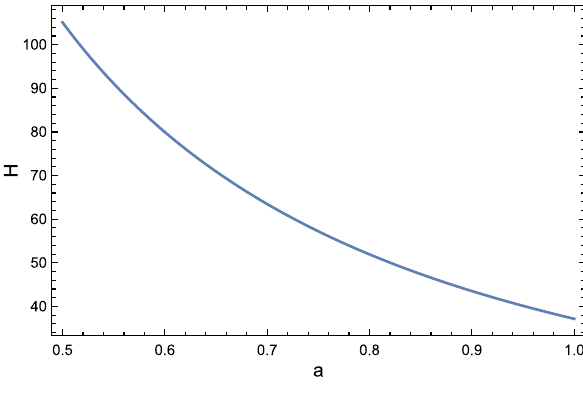
Fig. 1 Variation of H with